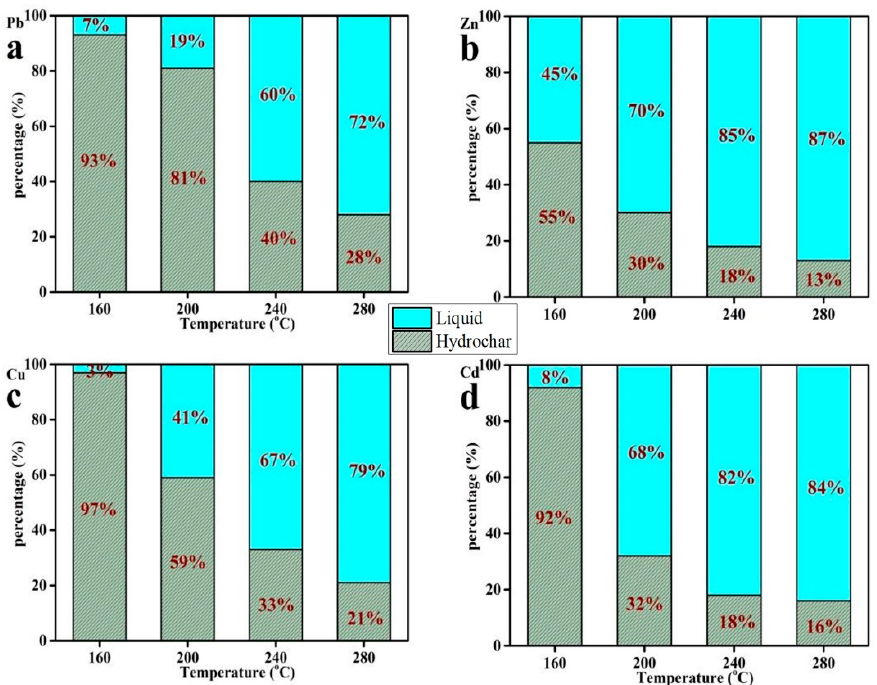
Figure 2. Different heavy metal fractions in liquid and hydrochar formed at different temperatures. Pb ( a ), Zn ( b ), Cu ( c ), Cd ( d ).